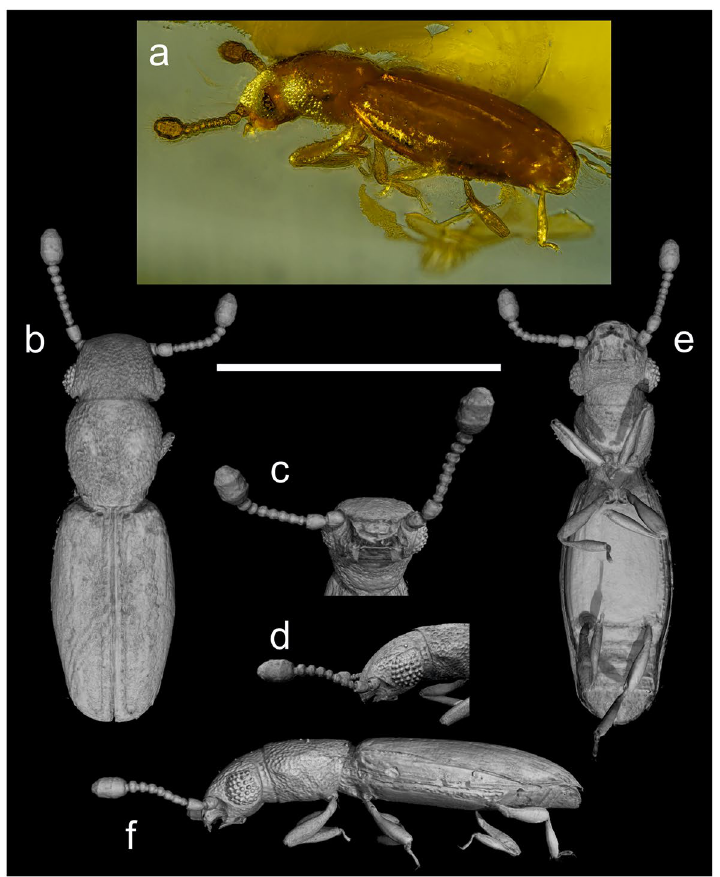
Figure 2. Specimen and virtual representation of Derolathrus cavernicolus in Tanzanian Holocene copal (210 ± 30 BP). Piece number SMF Be 3720.1a. ( a ) Specimen in dorso-lateral view. ( b ) Habitus in dorsal view. ( c ) Head in ventral view. ( d ) Head in lateral view. ( e ) Habitus in ventral view. ( f ) Habitus in lateral view. Scale bar 0.5